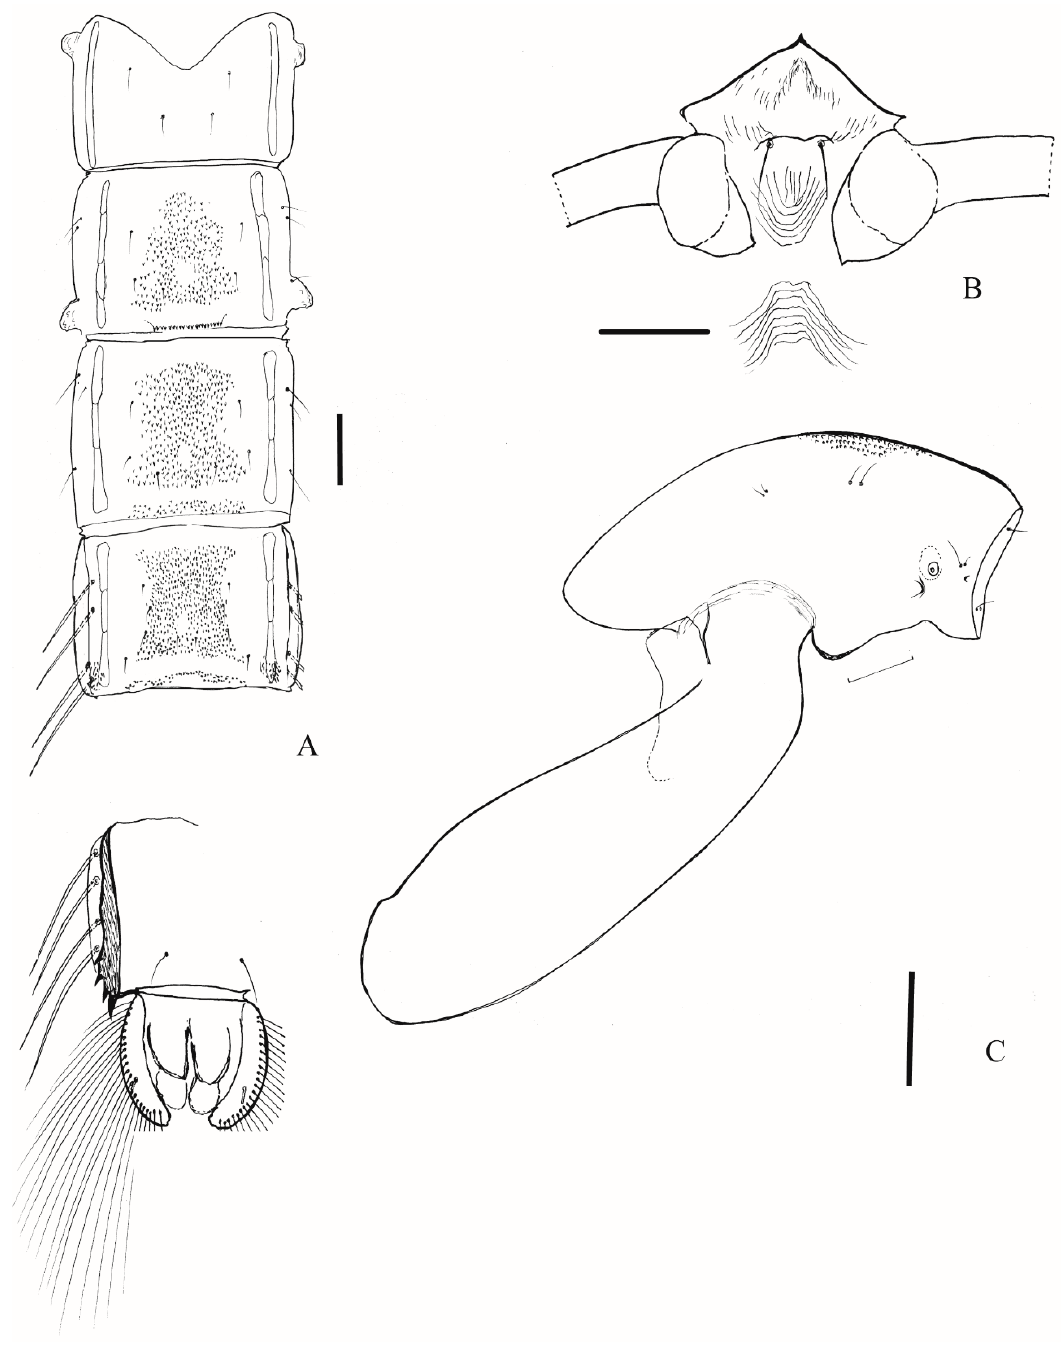
Figure 7. Y. balteatus sp. n. , pupa. Illustration: ( A ) abdomen, dorsal view; ( B ) cephalothorax; ( C ) thorax, lateral view. Scale bar: A–C, 100 µm.